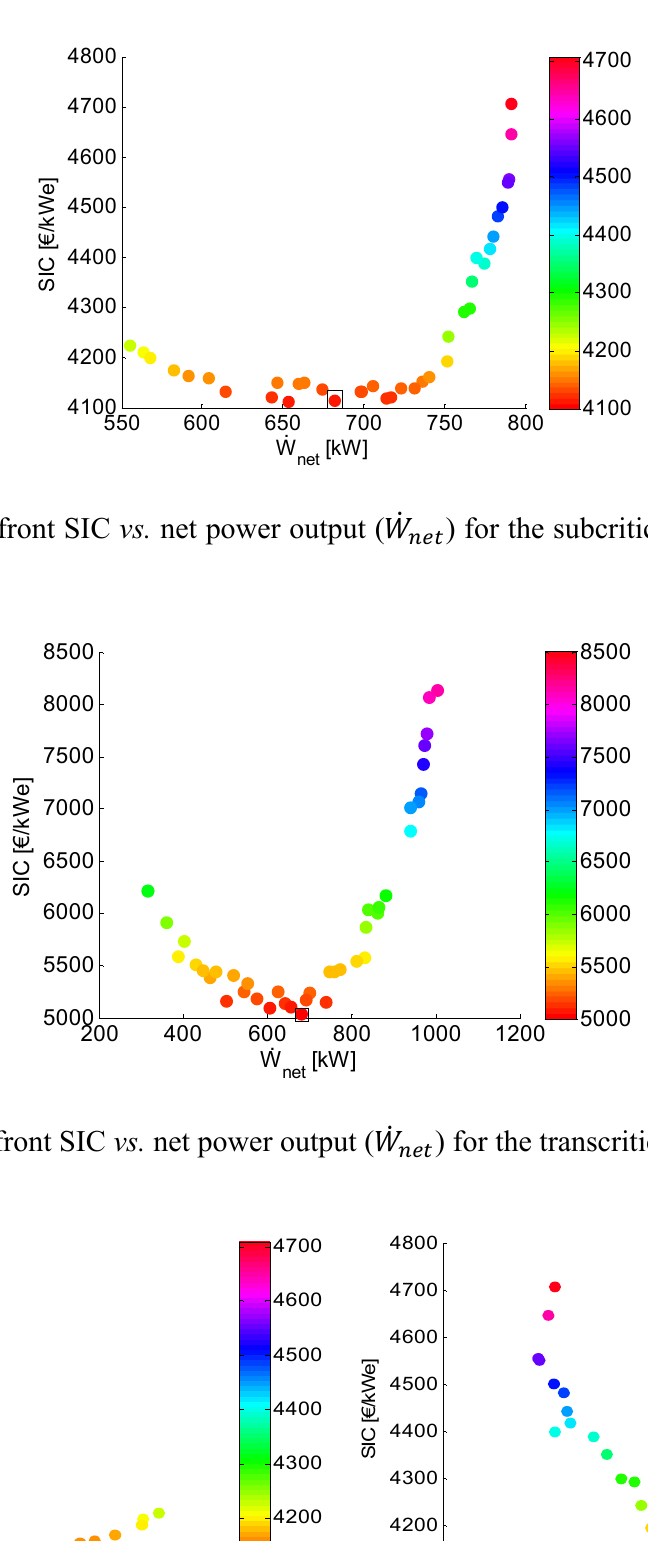
) and ( b ) pinch point (cid:3032)